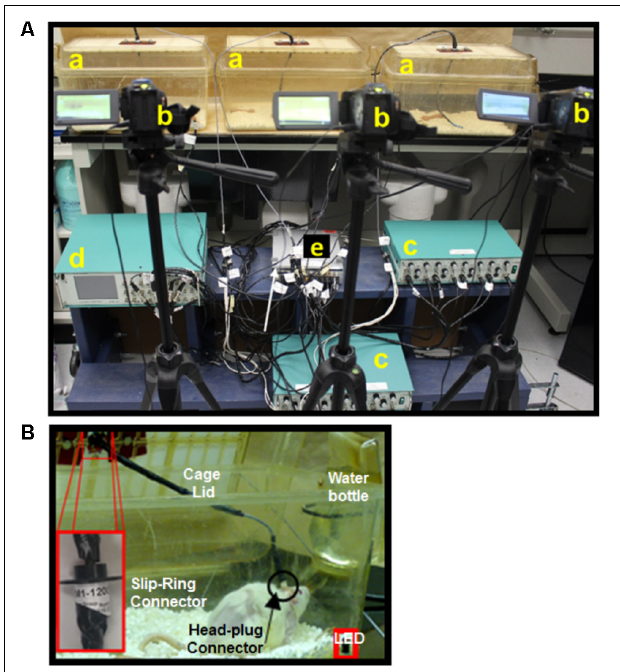
FIGURE 2 | Non-mobile experimental setup for long-term closed-loop spinal epidural stimulation (ES) in multiple rats. (A) Picture of the experimental setup showing multiple home cages (a) , cameras (b) , amplifiers (c) , a stimulator (d) , and a DAU (e) . (B) Picture of the rat in its modified home-cage allows full access to water without compromising movement due to the cable. A slip-ring connector (insert) linked to the head plug cable is attached into the cage lid and allows the rat a full 360 degrees of range of motion in the home-cage.